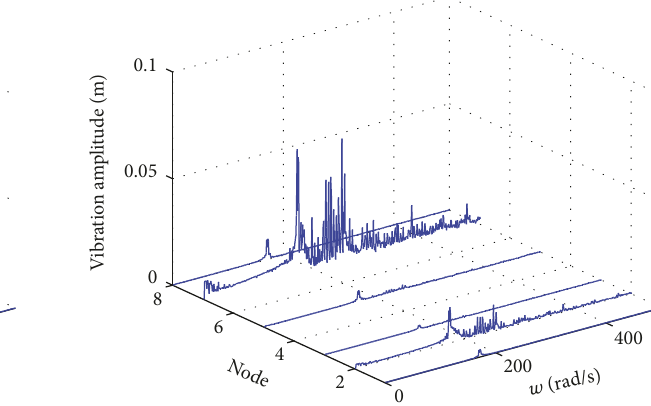
Figure 5: Original vibration of 1, 2, 3, 5, 7, and 8 nodes of the rotor.